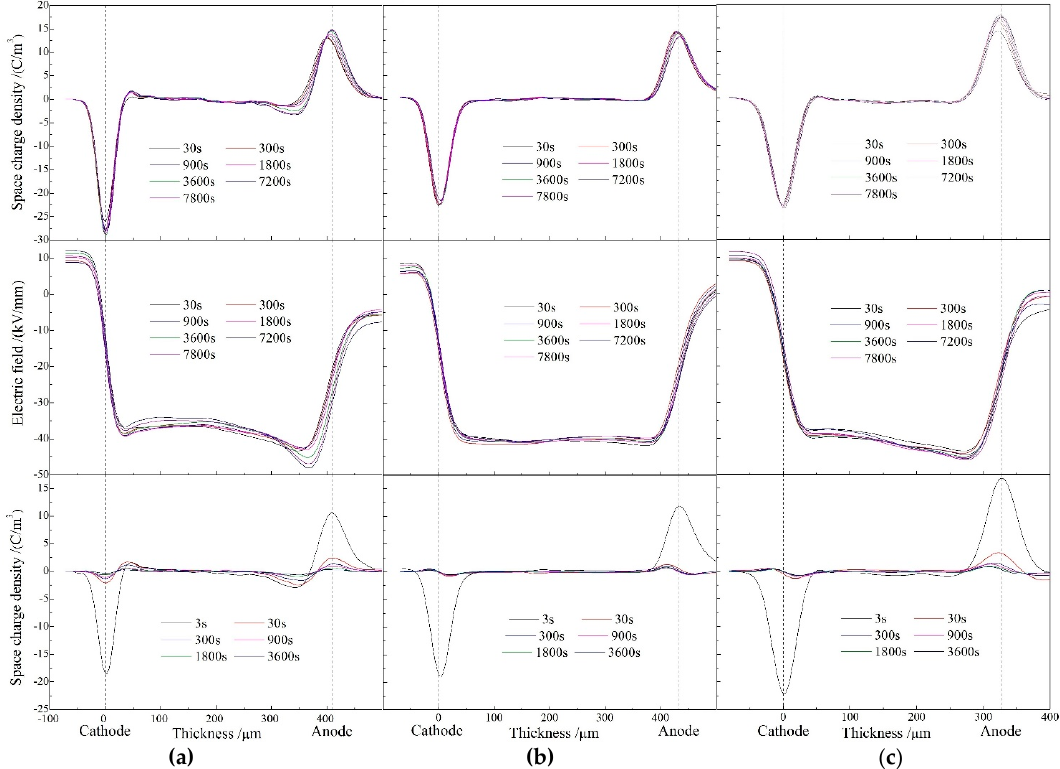
Figure 2. Space charge distributions at 25 °C in ( a ) XLPE, ( b ) XLPE-g-0.33wt%MAH, and ( c ) XLPE-g-0.41wt%MAH under applied DC electric field 40 kV/mm (upper panels) and in short-circuit (bottom panels).